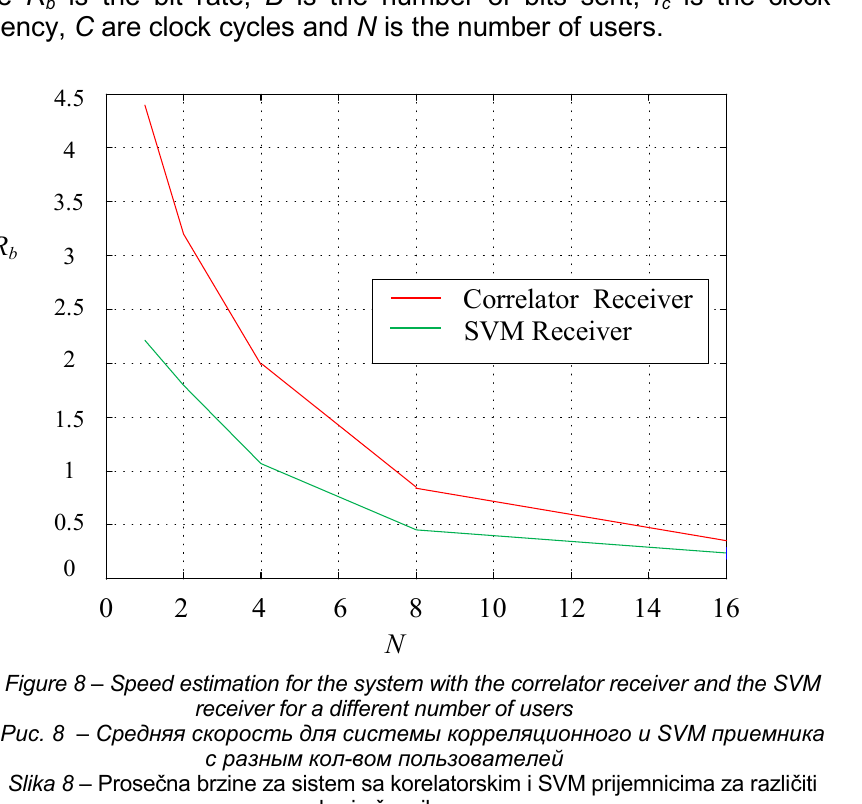
Figure 8 – Speed estimation for the system with the correlator receiver and the SVM receiver for a different number of users Рис . 8 – Средняя скорость для системы корреляционного и SVM приемника с разным кол - вом